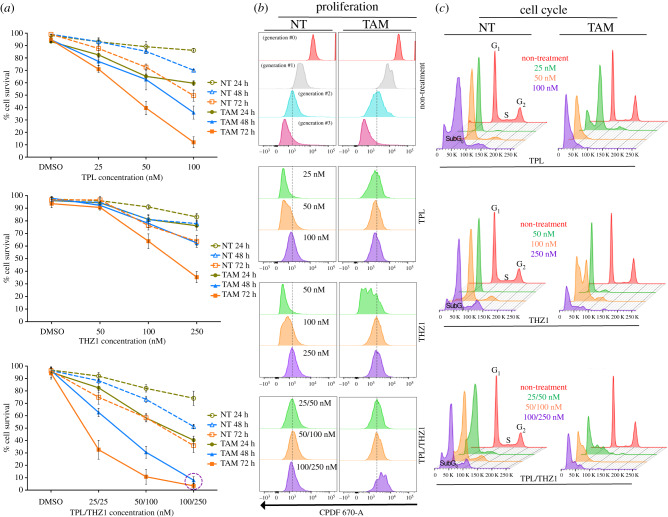
Triptolide (TPL) and THZ1 preferentially kill transformed cells and the combinatory of both substances potentiate their effect. Flow cytometry assays to determine cellular viability, proliferation and cell cycle arrest in tamoxifen-treated (TAM) and non-treated (NT) cells. (a) Cellular viability observed in cells incubated with TPL (upper panel), THZ1 (middle panel) and the combination of THZ1 and TPL (lower panel). The concentrations and incubation time used are indicated in the figure. Data are presented as mean values ± s.d. (standard deviation) from three independent experiments. (b) Proliferation assay in TAM and NT cells incubated with TPL (upper panel), THZ1 (middle panel) and the combination of THZ1 and TPL (lower panel). The first panel shows non-treatment cells throughout its generational duplications. (c) Cell cycle arrest assay in TAM and NT cells incubated with TPL (upper panel), THZ1 (middle panel) and the combination of THZ1 and TPL (lower panel). Graphs in (b) and (c) show concentrations used for 72 h of treatment and correspond a representative example from three biological replicates.